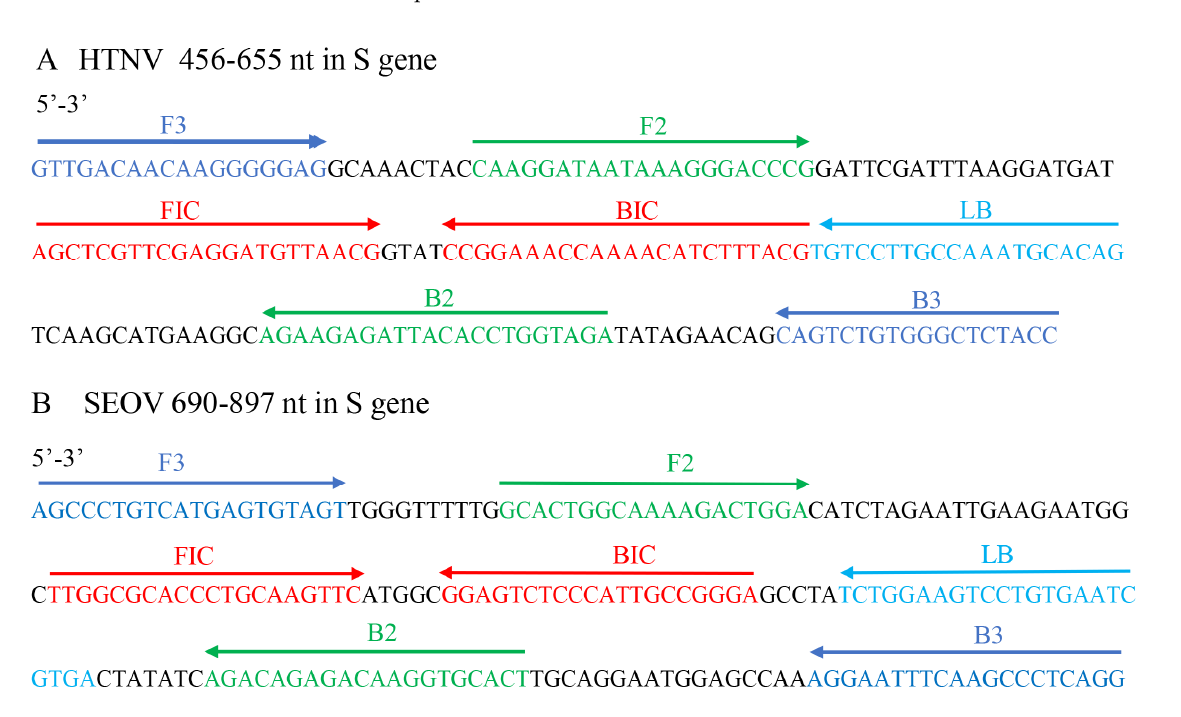
Figure 1. Genomic location and screening strategy of RT-LAMP primers for HTNV and SEOV. The location of each primer set is detailed in Table S1.